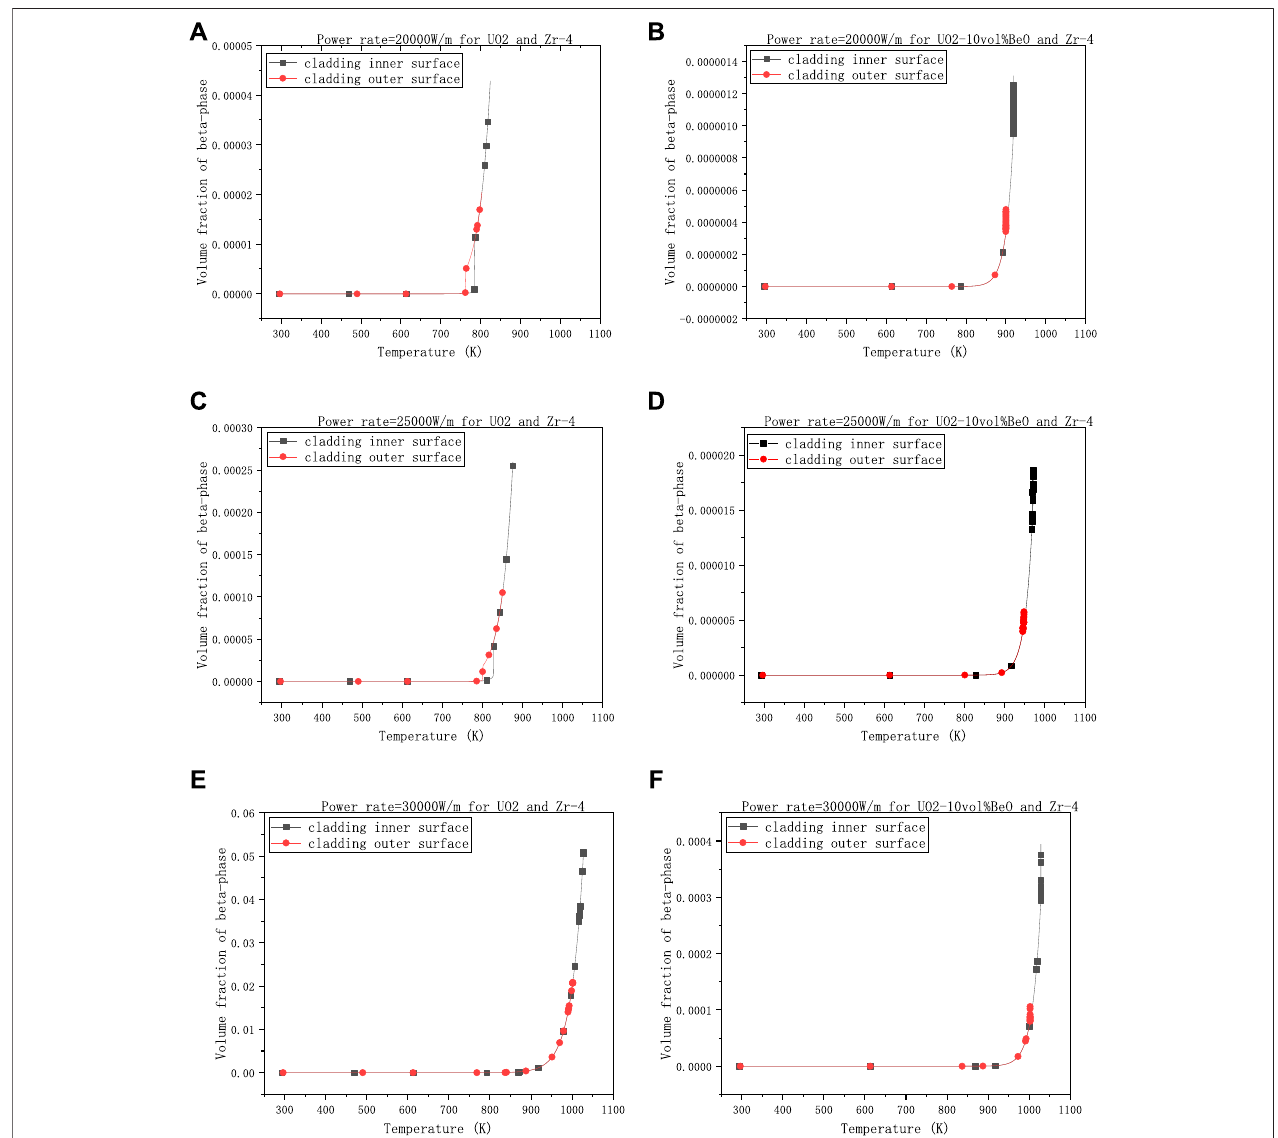
FIGURE 3| Volume fractions of β -phase on cladding inner surface and outer surface, changing with linear power rate, (A) 20,000 W/m for UO 2 and Zircaloy-4, (B) 20,000 W/m for UO 2 -10vol%BeO and Zircaloy-4, (C) 25,000 W/m for UO 2 and Zircaloy-4, (D) 25,000 W/m for UO 2 -10vol%BeO and Zircaloy-4, (E) 30,000 W/m for